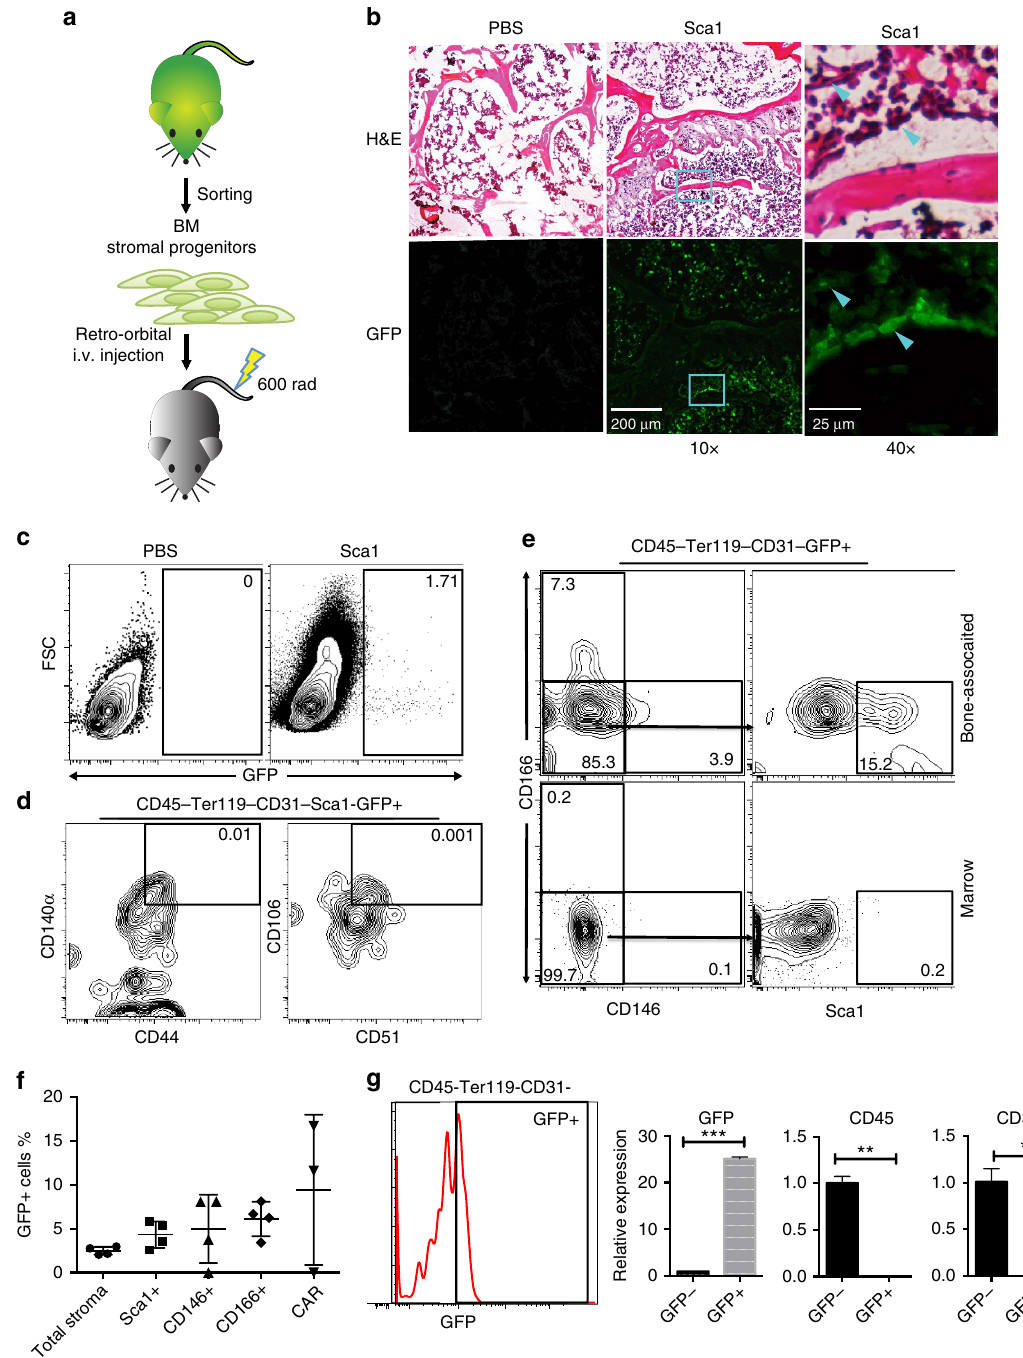
Figure 4 | Sca1 þ progenitors hometo the BM after intravenous transplantation into irradiated mice. ( a ) Intravenous transfusion of GFP-lablled mesenchymal progenitors into irradiated mice (600rad). ( b ) Representative cross sections of the tibia stained with H&E (upper) or GFP (lower). Tibias were harvested 1 month after transplantation. Blue arrows point to GFP þ stromal cells ( c – d ) FACS analysis of the marrow of recipients injected with Sca1 þ cells for ( c ) GFP expression or ( d ) phenotypes of CAR cells. ( e ) FACS analysis of donor-derived bone-disassociated progenitors (upper) and marrow stromal cells (lower). ( f ) Frequency of GFP þ cells in each group; mean ± s.d. ( n ¼ 4). ( g ) Histrogram of GFP to show the population that was sorted for RNA isolation (far left). Relative expression of GFP, CD45 and CD31 in GFP- and GFP þ sorted cells from CD45 (cid:2) Ter119 (cid:2) CD31 (cid:2) stromal cell gate (* P o 0.05, ** P o 0.005, *** P o 0.0005, mean ± s.d., technical triplicate, student’s t